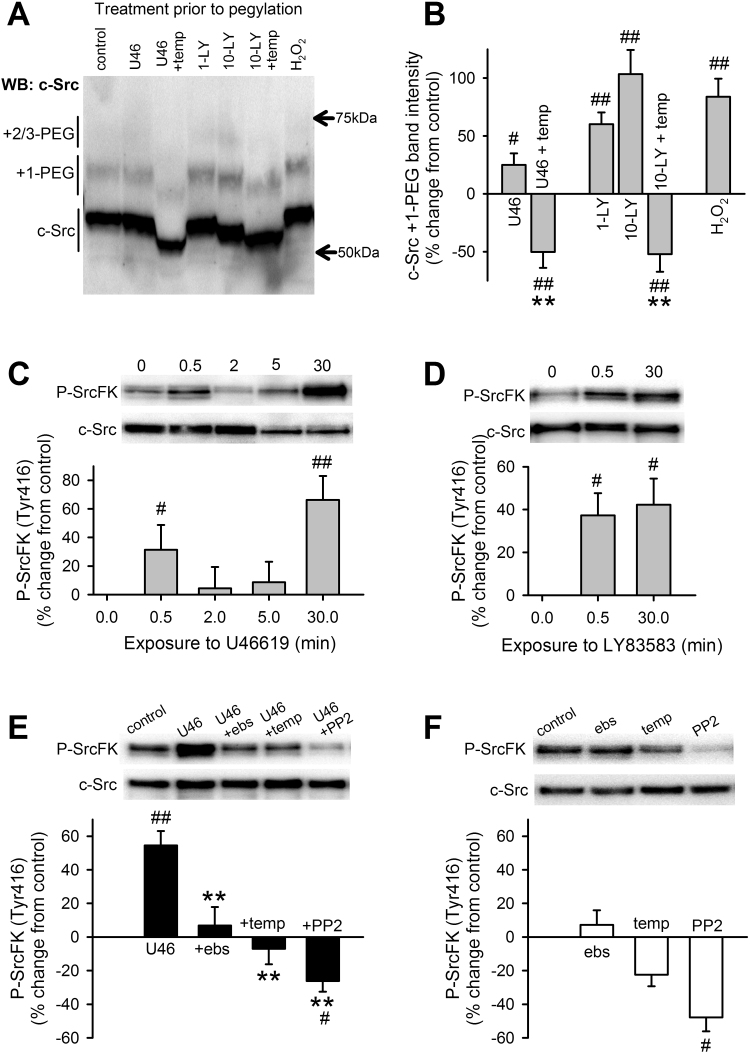
Effects of U46619, antioxidants and exogenous ROS on c-Src cysteine oxidation, and SrcFK auto-phosphorylation in IPA. A, B: c-Src cysteine oxidation in IPA is significantly enhanced by U46619 (U46, 100 nM, 30 min, n=9), LY83583 (LY, 1 or 10 µM, 30 min, n=7–8) and H2O2 (30 µM, 30 min, n=5). This enhancement and part of the underlying basal oxidation, is prevented by Tempol (temp, 3 mM, n=6–8). #P<0.05, ##P<0.01 vs. control, **P<0.01 vs. U46 only or vs. 10-LY only (1-way ANOVA). C: U46619 (100 nM) time-dependently enhances SrcK auto-phosphorylation (Tyr416) in IPA (n=9, #P<0.05 vs. control, ##P<0.01 vs. control, 1-way ANOVA). D: In the absence of U46, SrcFK auto-phosphorylation is significantly enhanced by LY83583 (1 µM) at 0.5 min (n=16) and 30 min (n=7), #P<0.05 vs. control (1-way ANOVA). E: At 30 min, U46619-induced SrcFK auto-phosphorylation is inhibited by ebselen (ebs, 10 µM, n=14), Tempol (n=11) or PP2 (30 µM, n=10) #P<0.05 vs. control. F: In the absence of U46, SrcFK auto-phosphorylation is unaffected by ebselen (n=10) or Tempol (n=10) but significantly inhibited by PP2 (n=8), ##P<0.001 vs. control, **P<0.001 vs. U46 alone (n=19, 2-way ANOVA).